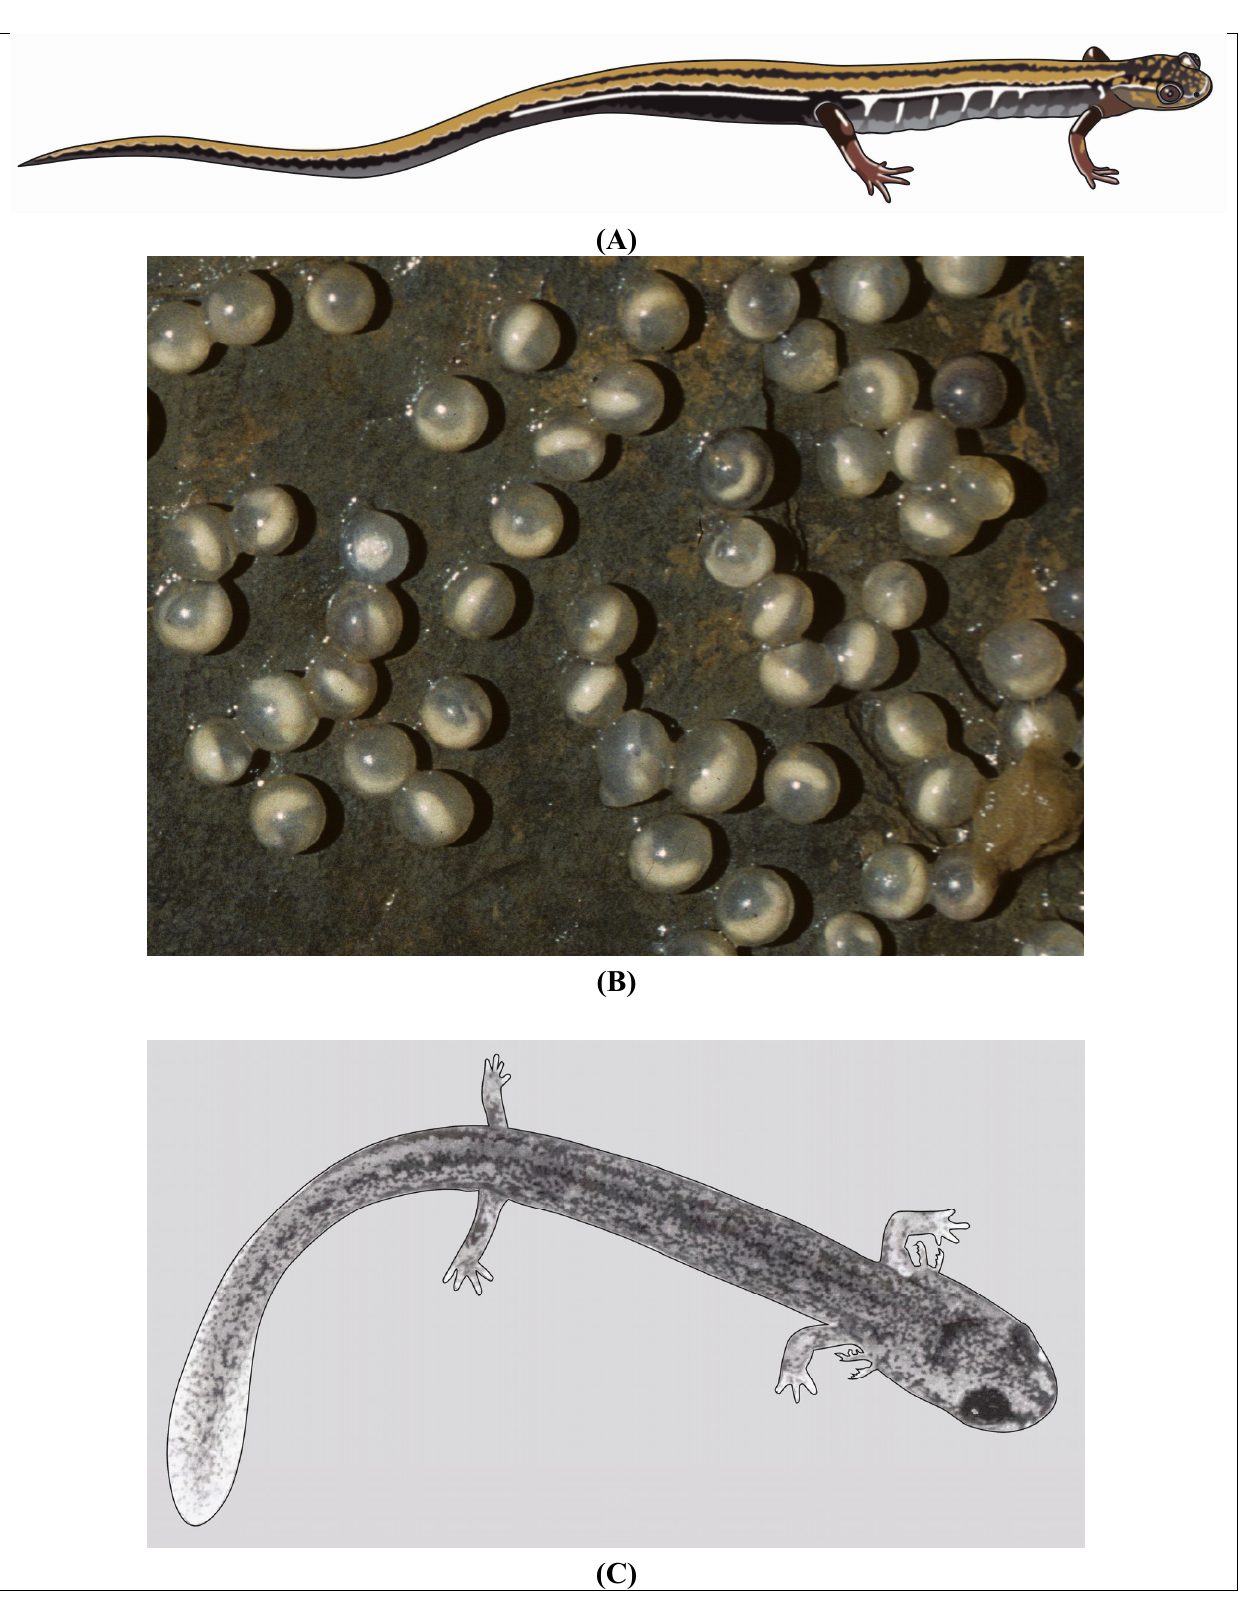
Figure 1. Golden-striped salamander, Chioglossa lusitanica : ( A ) adult, drawing and copyright Bas Blankevoort © Naturalis Biodiversity Center, reproduced from [6] with permission; ( B ) embryos in various stages of development, Photo M. Sparreboom; and ( C ) first-year larva, Photo